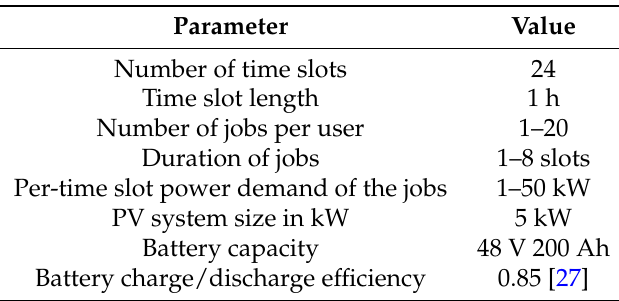
Figure 4. Solar irradiance measurements on 1 June 2015 from the public BMS dataset of the National Renewable Energy Laboratory [26]. Table 4. Experimental